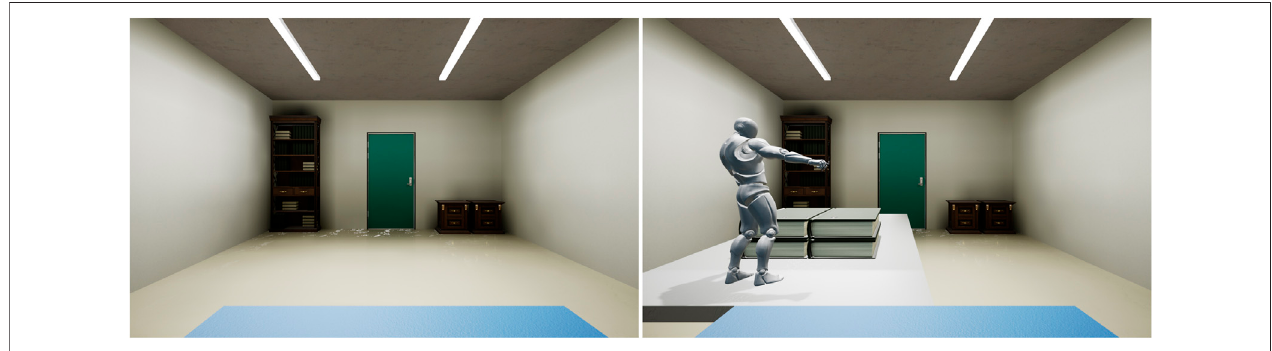
FIGURE 2 | Virtual environment as seen by participants: during stimulation and cube estimation phases (left), during physics estimation task